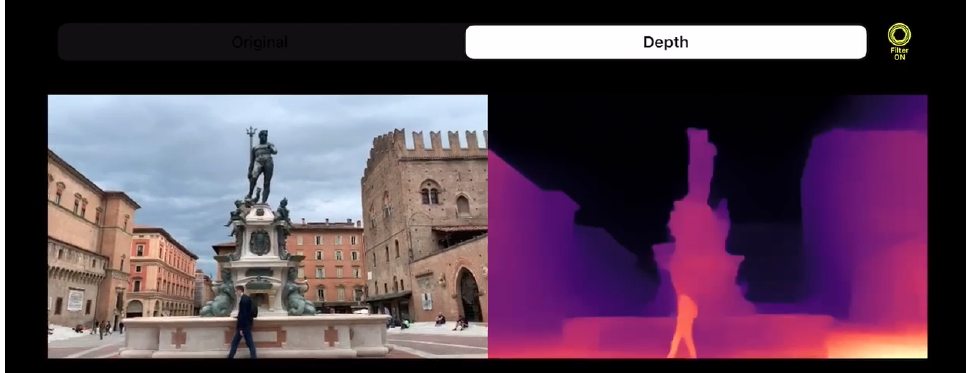
Figure 1. Depth perception in the wild with a mobile application. Single image depth perception in the wild at nearly 60 FPS with an iPhone XS and the PyDNet [6]